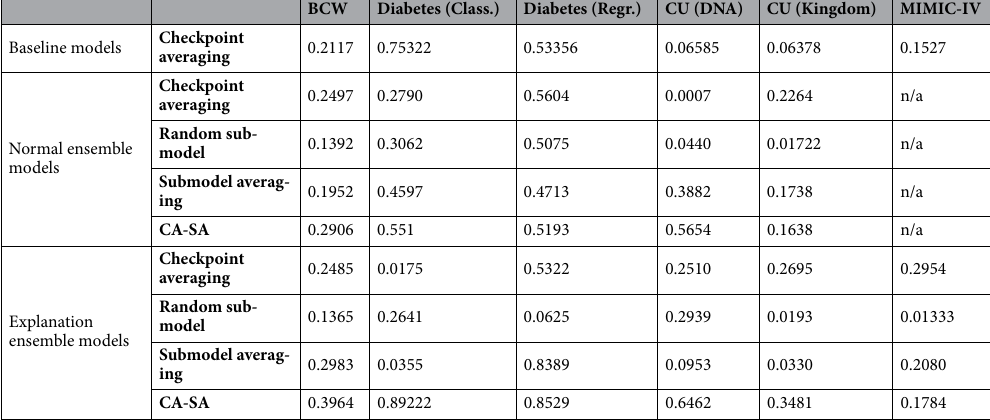
Table 5. Explanation consistency, C , of checkpoint averaging, submodel averaging and random submodel picking on baseline models and both normal and explanation ensembles. CA-SA is checkpoint averaging followed by ensemble submodel averaging, CU the Codon Usage dataset, class. is classification and regr.